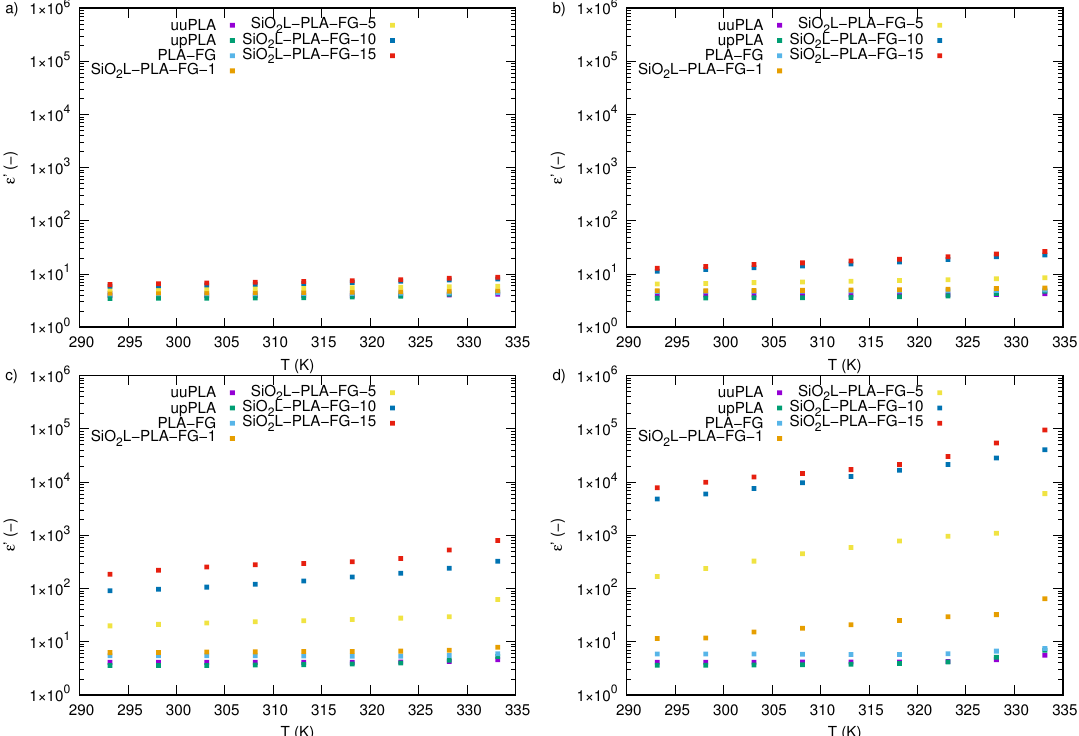
Figure 5. The real part of the complex permittivity of silicon-dioxide–lignin nanocomposites as a function of temperature for ( a ) 0.1 Hz, ( b ) 10 Hz ( c ) 1 kHz, and ( d ) 1